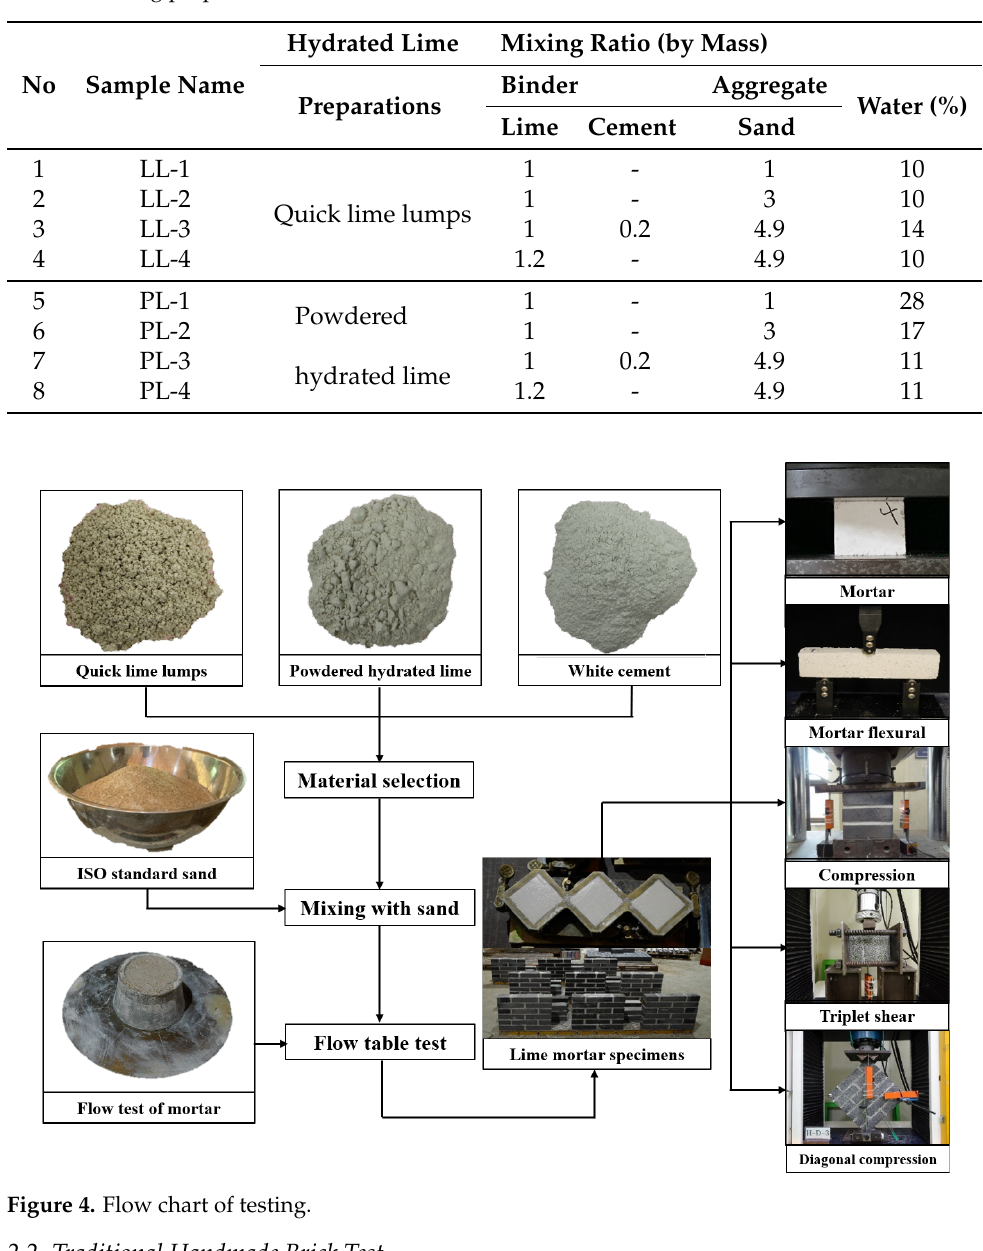
Figure 4. Flow chart of